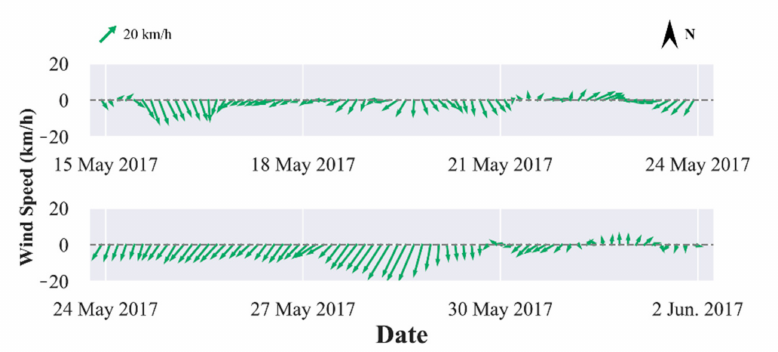
Figure 5. Wind speed and orientation (3 h) near the northern ice arch from 15 May 2017 to 3 June